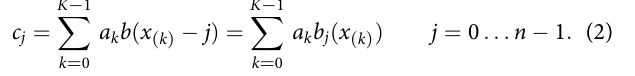
Fr ontiers in Robotics and AI |